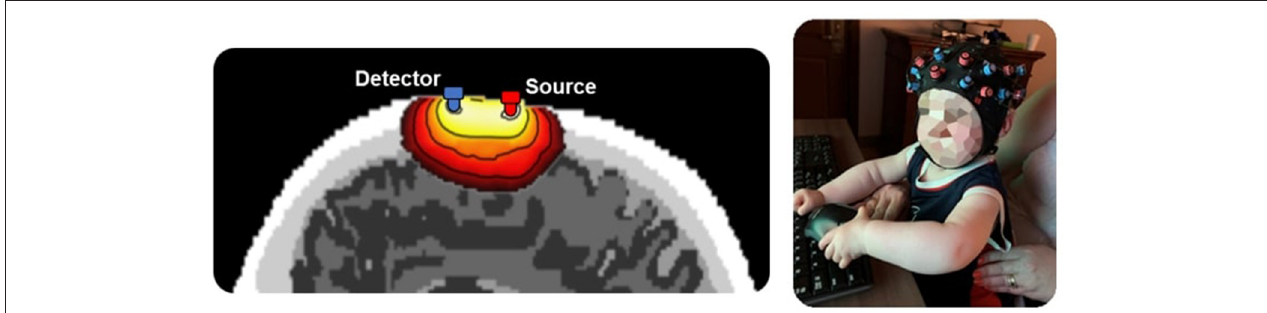
FIGURE 3 | Left – A diagram of near infrared light probing from location of source through cortical region. Light intensity that is backscattered is measured by a detector. Changes in the light intensity as measured by the detector will be converted to changes in oxy-hemoglobin and deoxy-hemoglobin. Right – Several combinations of sources and detectors are used to cover the cortical